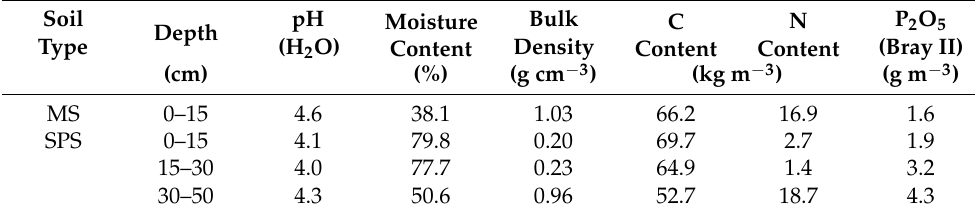
Table 1. Soil physicochemical properties.